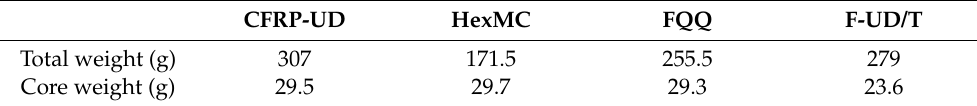
Figure 6. Image showing the end products of the fuselage. Table 2. Mass of the fuselages .